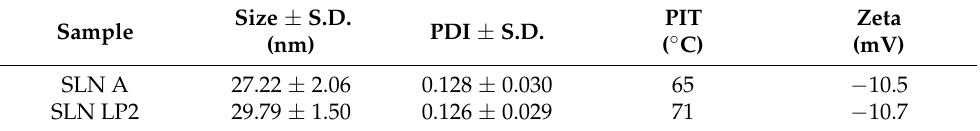
Table 1. Mean size (size), polydispersity index (PDI), phase inversion temperature (PIT), and ζ - potential (Zeta) of unloaded (SLN A) and LP2-loaded